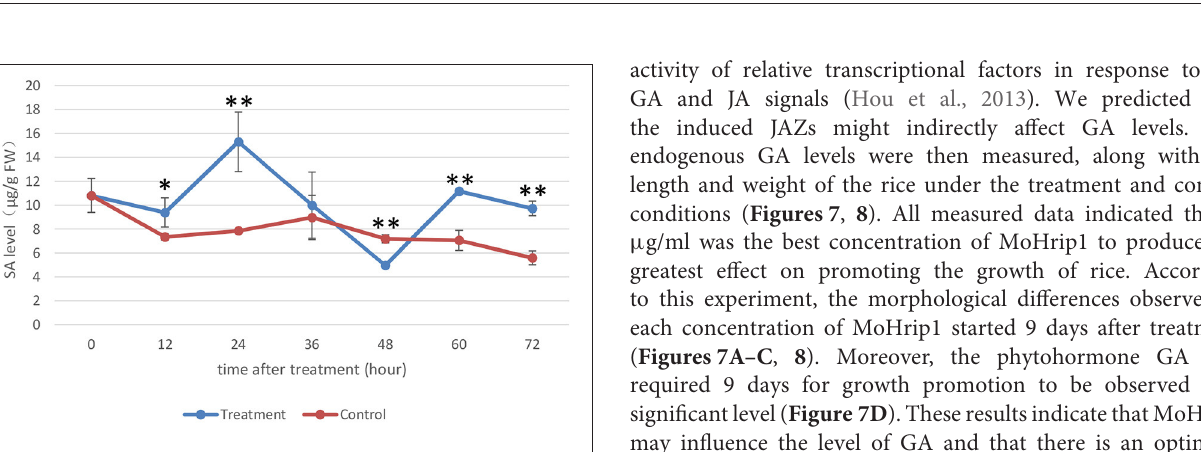
FIGURE 6 | Endogenous SA levels of rice. The SA levels ( µ g/g FW) on the y-axis were relative to those of non-treated rice (NoT0). The experiment was repeated three times, and the data are presented as the average ± SD with n = 3. Asterisks indicate statistically significant differences, as measured